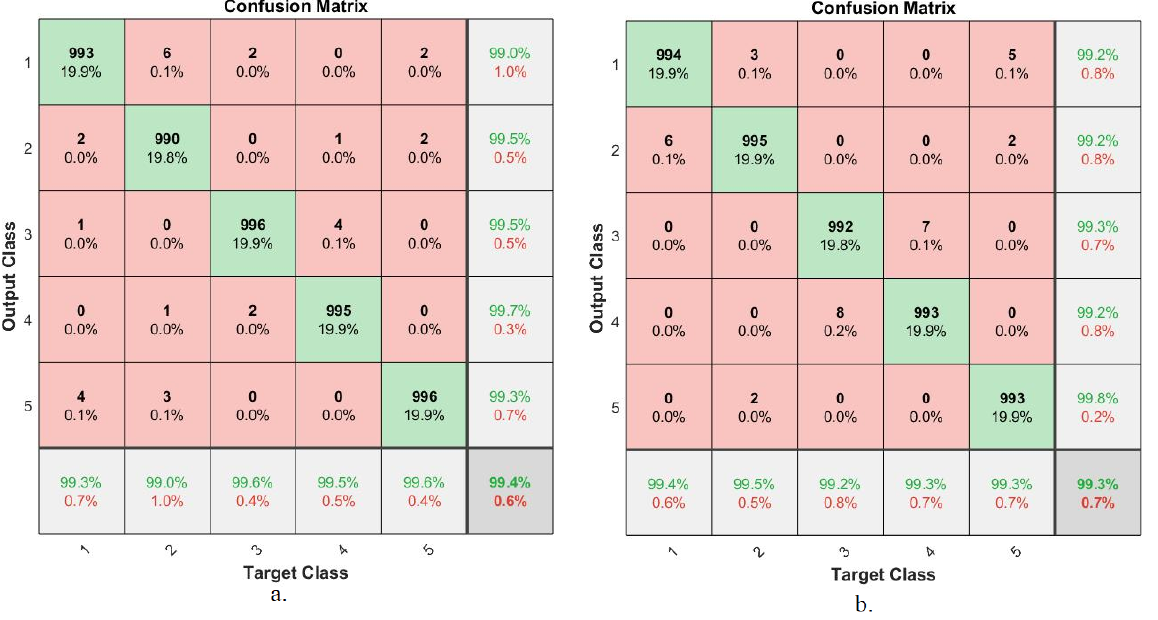
Figure 13. Confusion matrix for diagnosing abnormal cell images of the cervix by ANN based on the features of ( a ). VGG ‐ 16, FCH, GLCM and LBP and ( b ). GoogLeNet, FCH, GLCM and LBP.